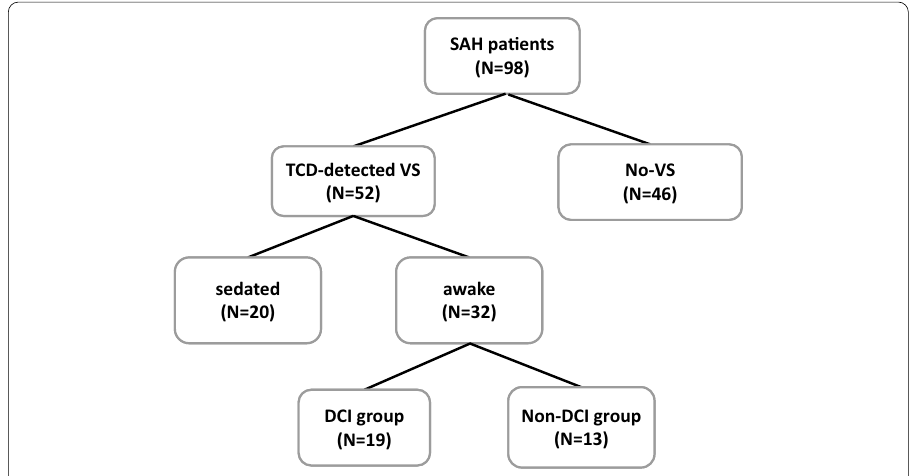
Fig. 1 Flowchart of the study. From an initial data base of 98 patients with subarachnoid hemorrhage (SAH), 52 subjects with TCD-detected vasospasm (VS) were selected. Subsequently, 32 awake patients were included in the study and were further dichotomized in delayed cerebral ischemia (DCI) and non-DCI groups ( N 19 and N 13, = =